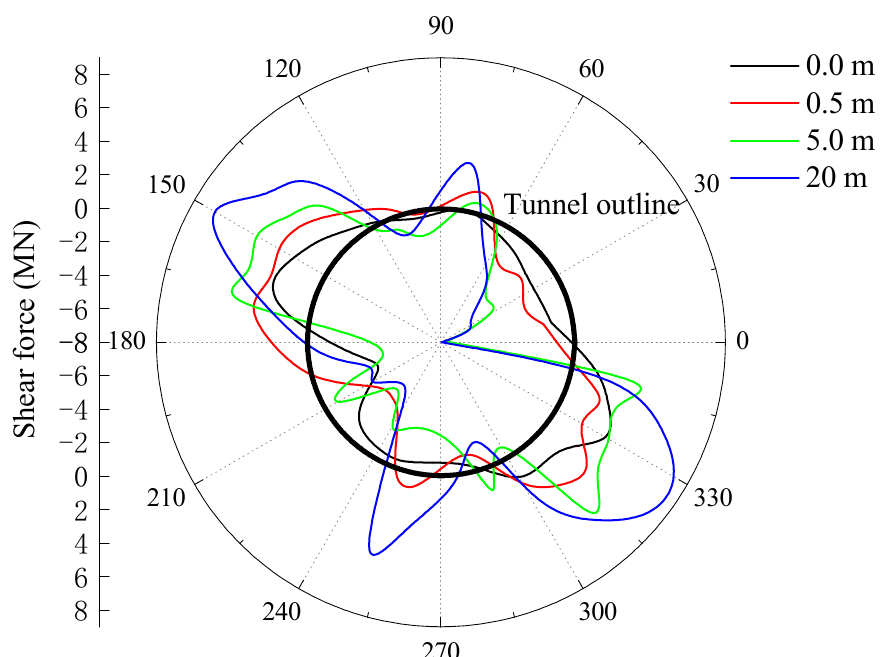
Figure 12. Shear force of lining of the tunnel passing through adverse geological structure zone with different thicknesses for cross section at y = 500 m.